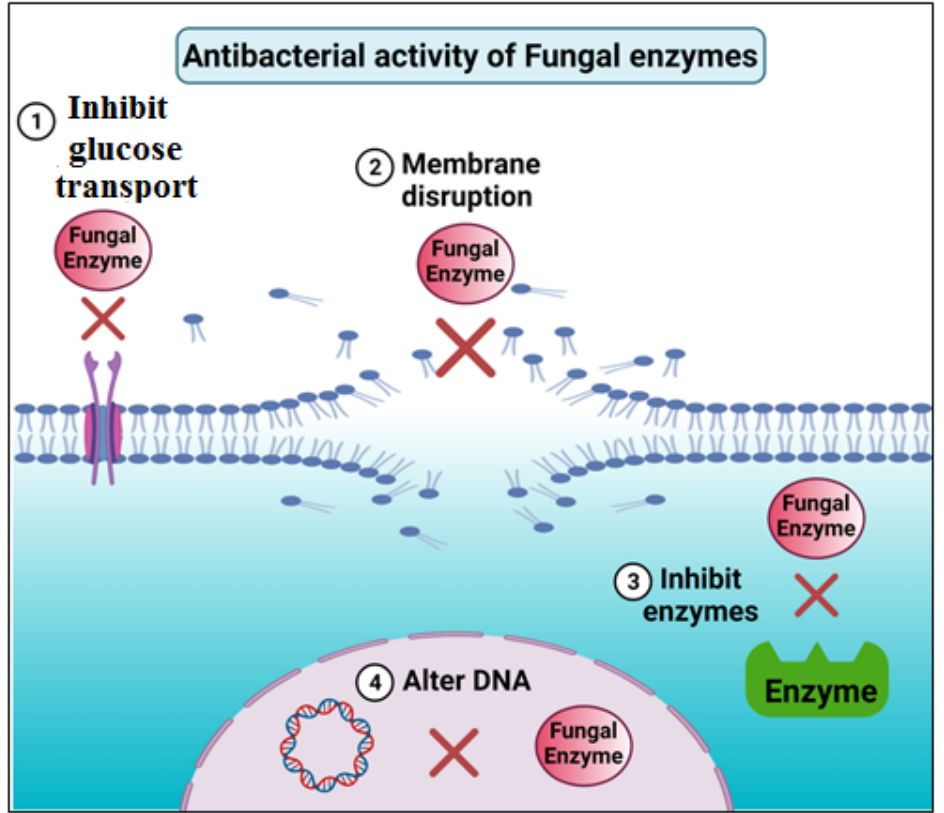
Figure 4. Schematic illustration represents the molecular mechanisms of the main antibacterial effects of fungal enzymes, including 1. alter membrane permeability and inhibition of glucose transport, 2. bacterial membrane damage and disruption, causing cytoplasm leakage, 3. inhibit bacterial enzymes, and 4. inhibit or alter cell division and the DNA replication process.